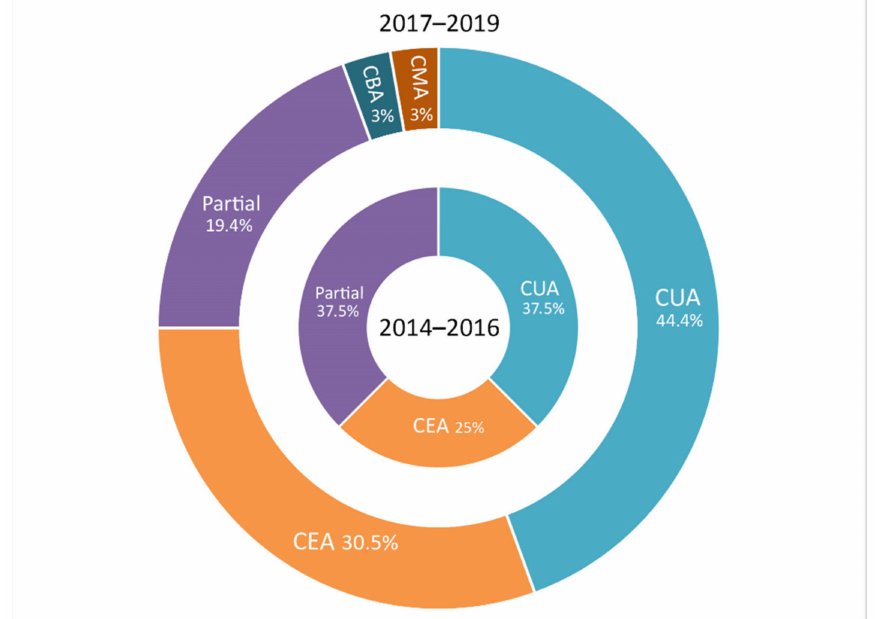
Figure 4. Type of economic evaluations carried out in the studies included according to the triennium. Note: CUA: cost-utility analysis; CEA: cost-effectiveness analysis; CBA: cost-benefit analysis; CMA: cost minimization